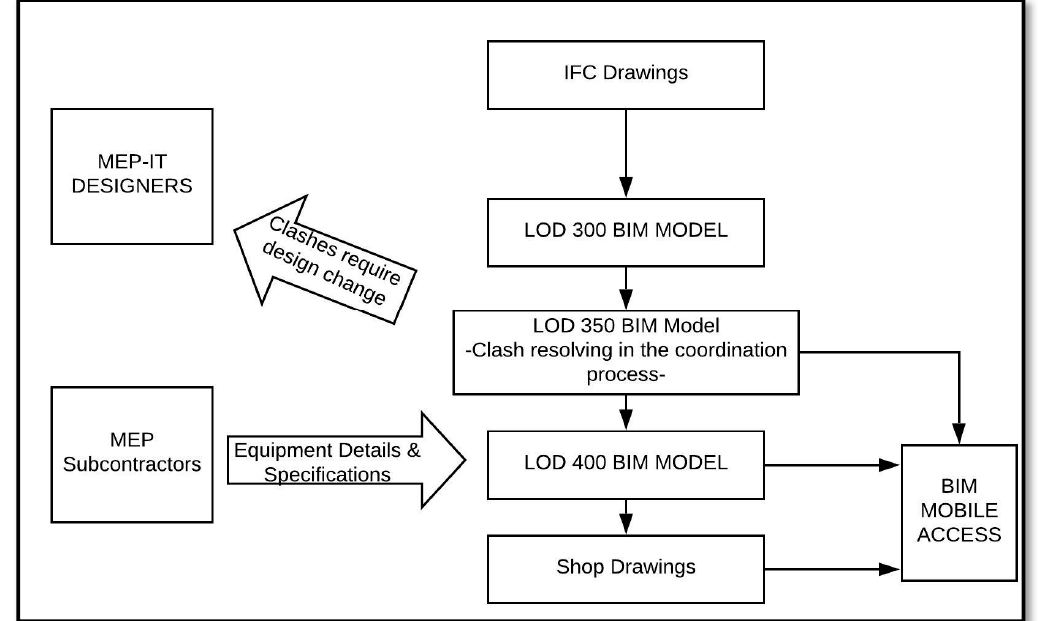
Figure 9. MEP-IT Coordination Workflow.